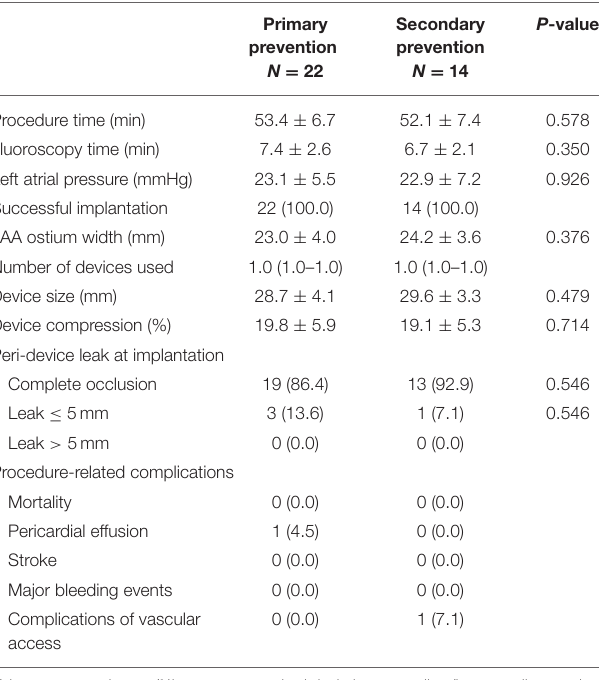
TABLE 2 | Procedural characteristics and